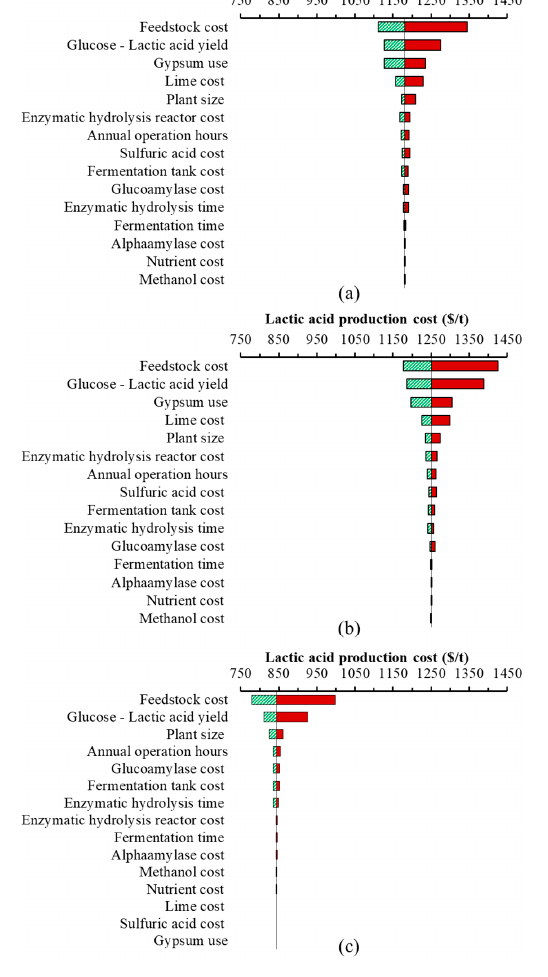
Figure S1: Detailed process flow of the processes (obtained from the SuperPro Designer software), Table S1: Technical data related to the equipment (base size, base cost, scale factor, number, size and